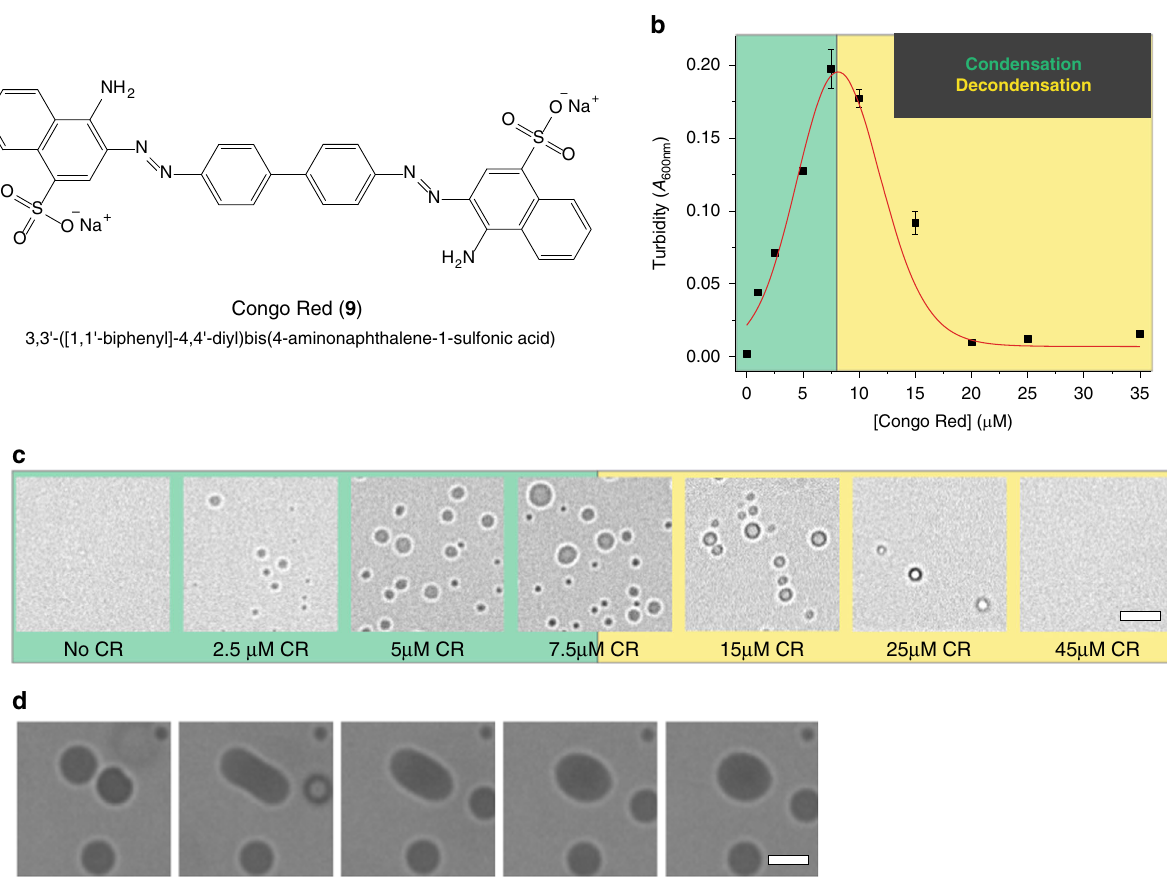
Fig. 5 Congo red modulates the phase behavior of the TDP-43 LCD. a Chemical structure of Congo red (CR, 9 ). b Turbidity of TDP-43 LCD (untagged; 5 μ M) as a function of Congo red concentration. c Representative bright fi eld microscopy images of CR/TDP-43 LCD system. d Representative images of CR/TDP-43 LCD droplet fusion event (molar ratio of CR to TDP-43 of 1.3:1). Scale bars: 5 μ m. Experiments were performed in a 20 mM potassium phosphate buffer, pH 6.0. All data are presented as mean values ± standard deviation ( n = 3 technical